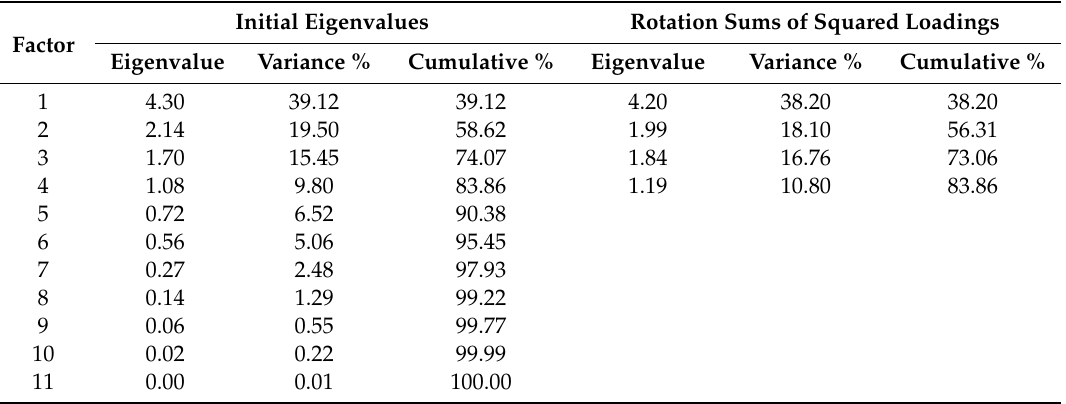
Table 3. Eigenvalues and percent of variance for the factor analysis of the physico-chemical parameters. Initial Eigenvalues Rotation Sums of Squared Factor